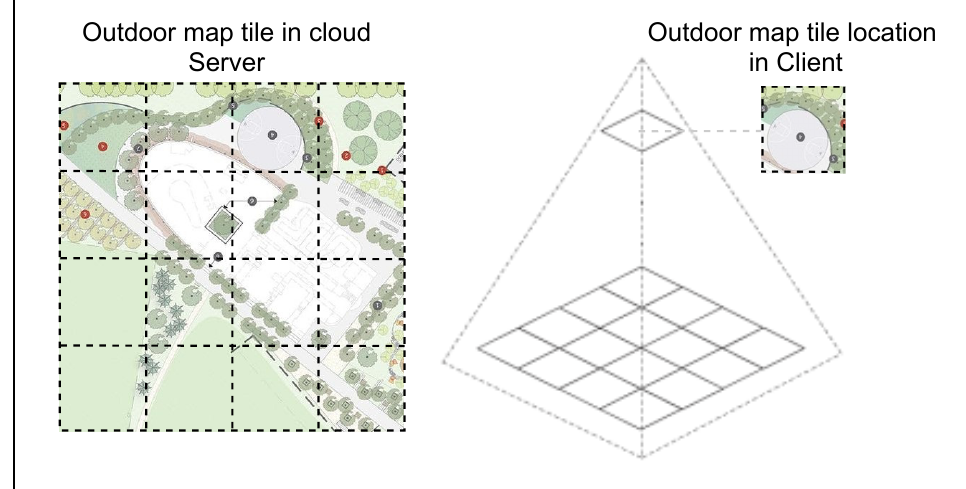
Figure 4. Outdoor map tile